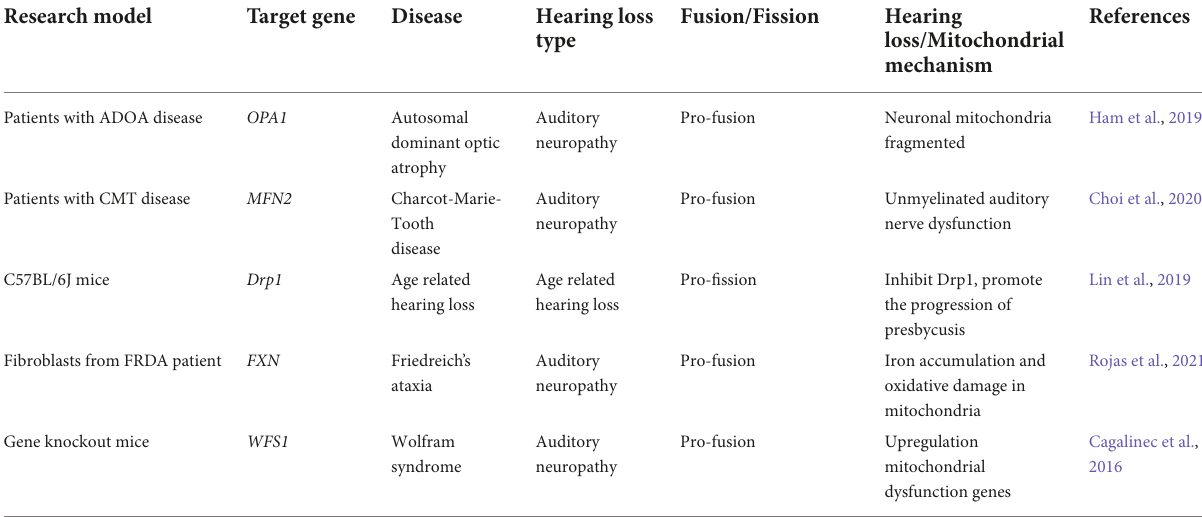
TABLE 1 Mitochondrial dynamics dysfunction induced hearing